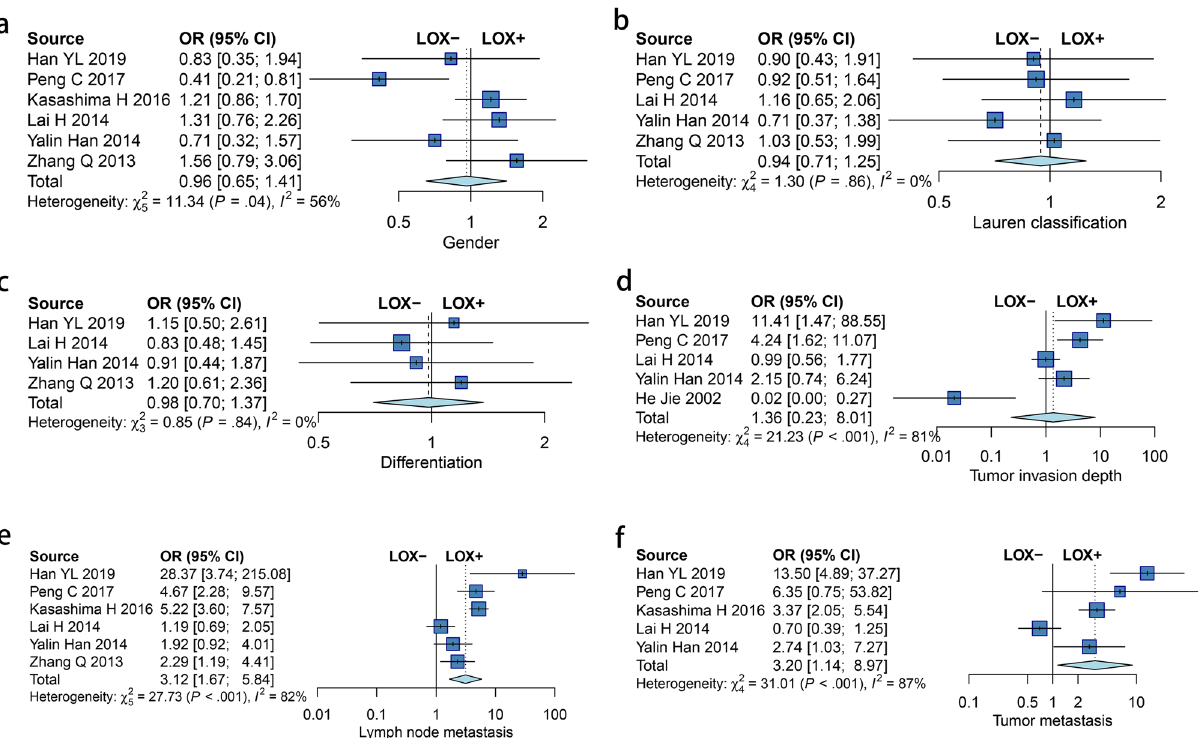
Figure 2. Forest plot for the relationship between LOX expression and clinicopathological characteristics: gender ( a ), Lauren classification ( b ), differentiation ( c ), depth of invasion ( d ), lymph node metastasis ( e ) and tumor distant metastasis ( f